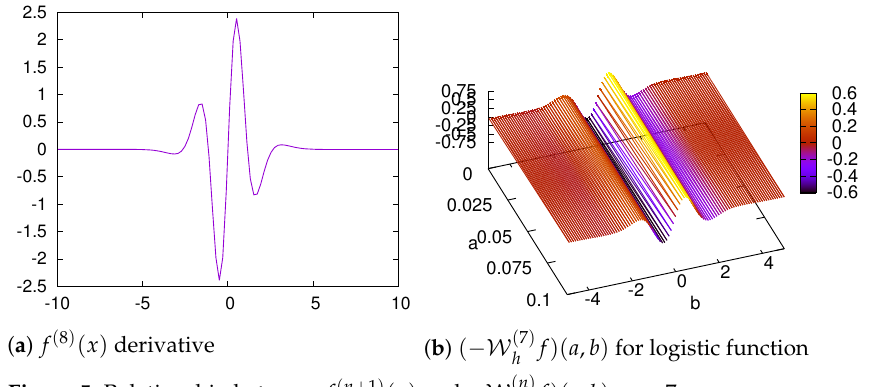
Figure 5. Relationship between f ( n + 1 ) ( x ) and −W